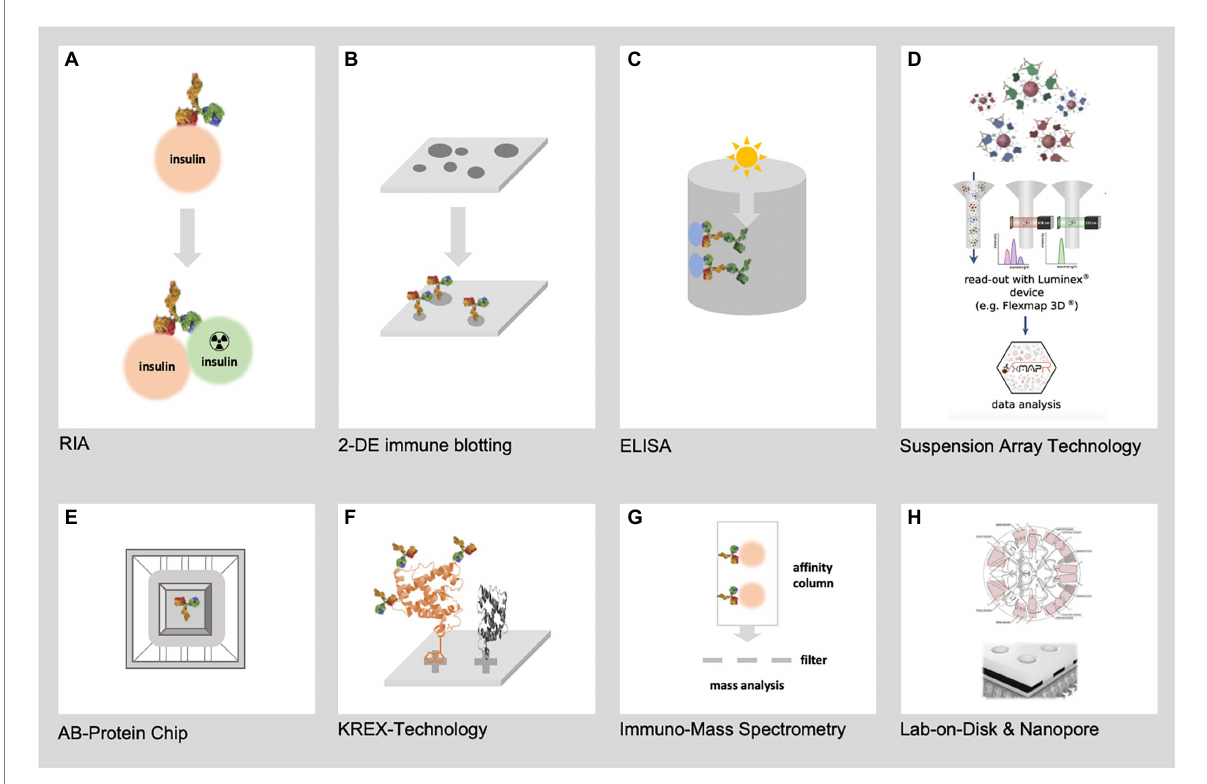
FIGURE 2 Represents the most relevant techniques for immunoproteomics. (A) First immunoproteomics approach (RIA) to detect AB against insulin (B) 2-DE immune blotting combining 2-DE electrophoresis of hundreds of native pathogen proteoforms and Western blotting (C) Classical